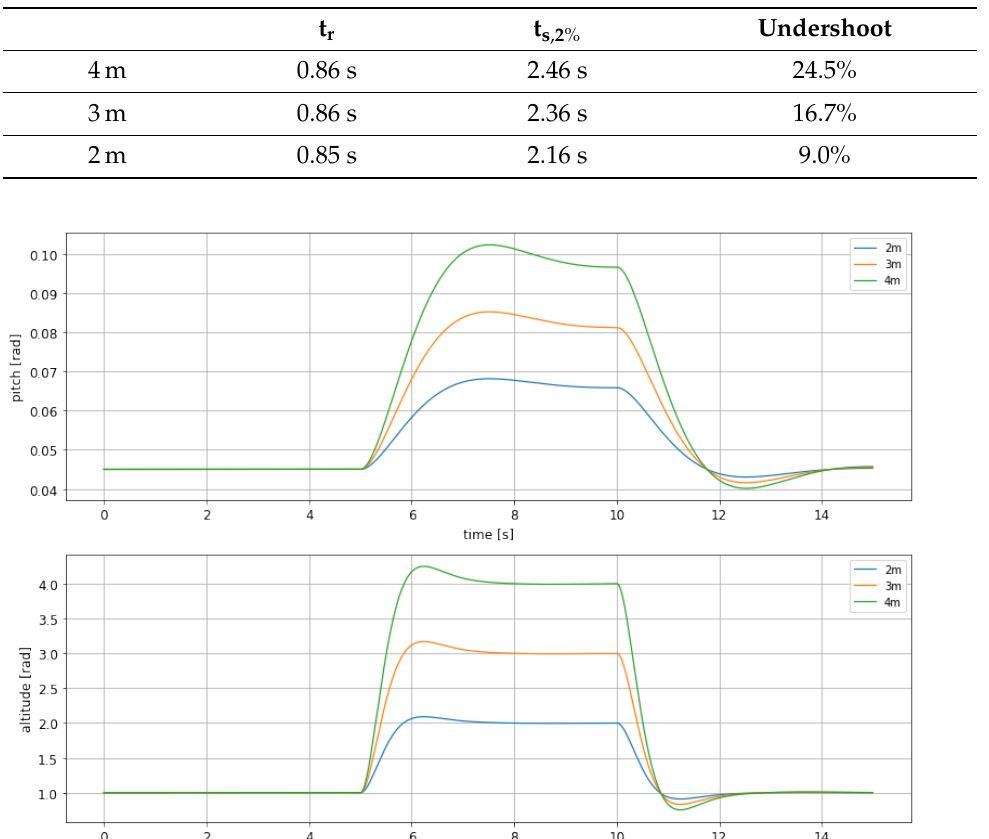
Table 10. Height undershoot for different altitudes using adaptive LQR, descent.